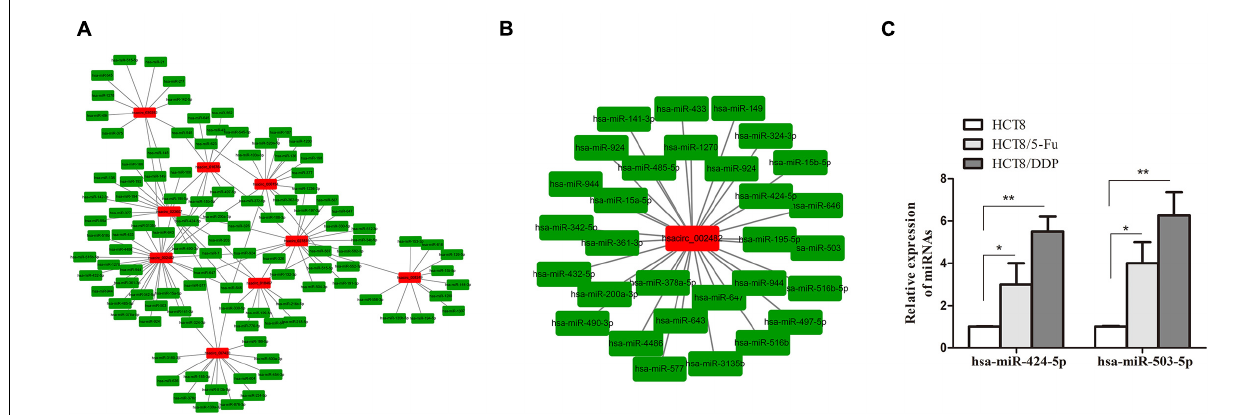
FIGURE 6 | Prediction of circRNA–miRNA regulatory networks. (A) The network of targeting miRNAs of common DE-circRNA related to cancer resistance to 5-Fu or cisplatin. (B) The regulatory network of the hub gene hsacirc_002482 targeted miRNAs related to 5-Fu or cisplatin resistance. (C) The expression levels of hsa-miR-424-5p and hsa-miR-503-5p in chemoresistant and chemosensitive cell lines were determined by qRT-PCR. n = 3, data are shown as mean ± SD, * p < 0.05 and ** p < 0.01.